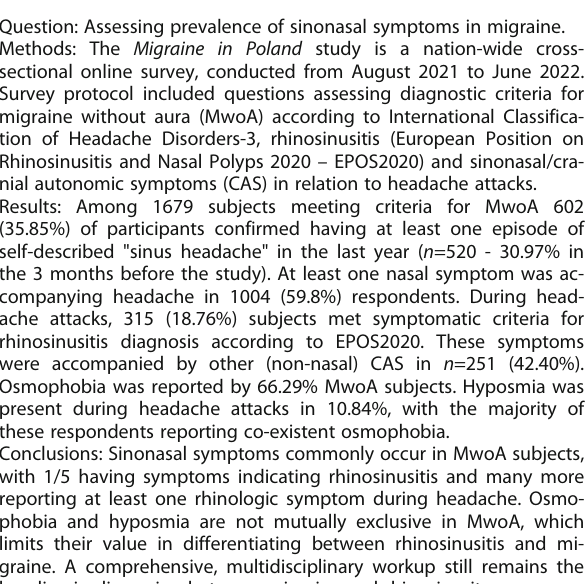
Fig. 1 (abstract P152). See text for description.